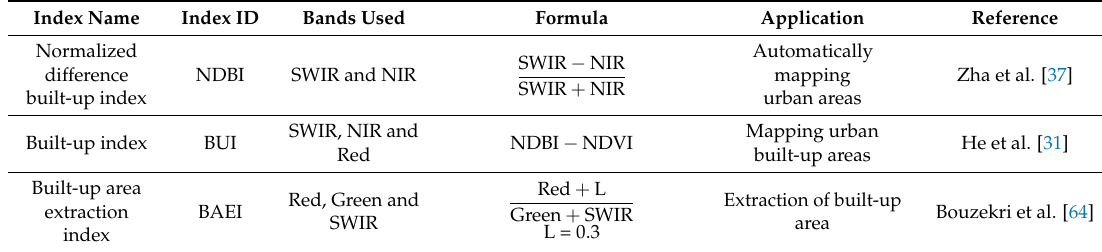
Table 2. Existing built-up